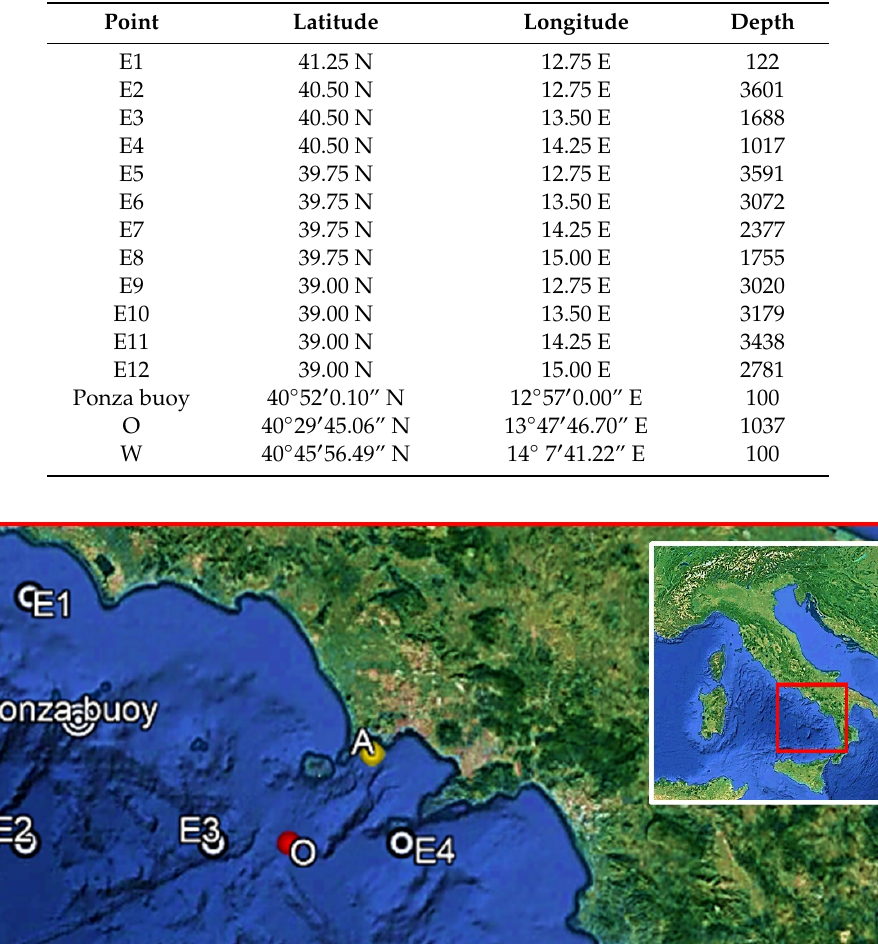
Table 1. Geographical information of ECMWF grid points E1–E12, Ponza wave buoy and reference point O (o ff shore of the Gulf of Naples) and point W (o ff shore Pozzuoli’s Gulf).